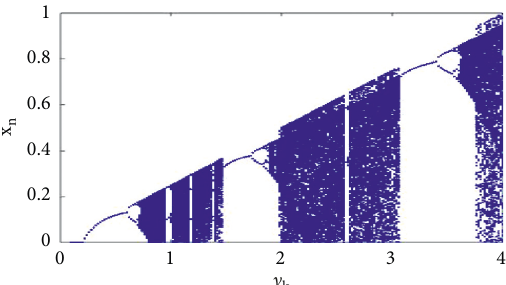
Figure 7: Bifurcation diagram of system (36) by using x